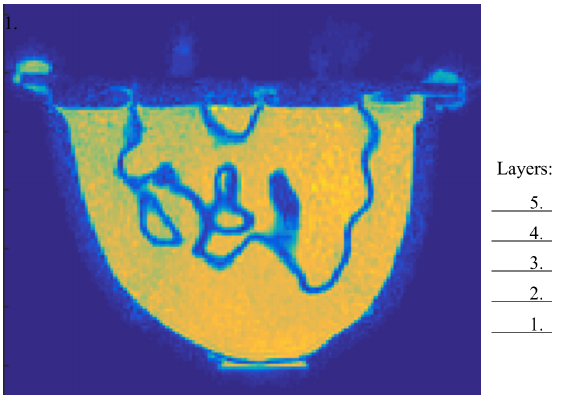
Figure 3. Cross section of an MRI scan of the GeePS-L2S phantom. The positions of the five imaging planes are marked